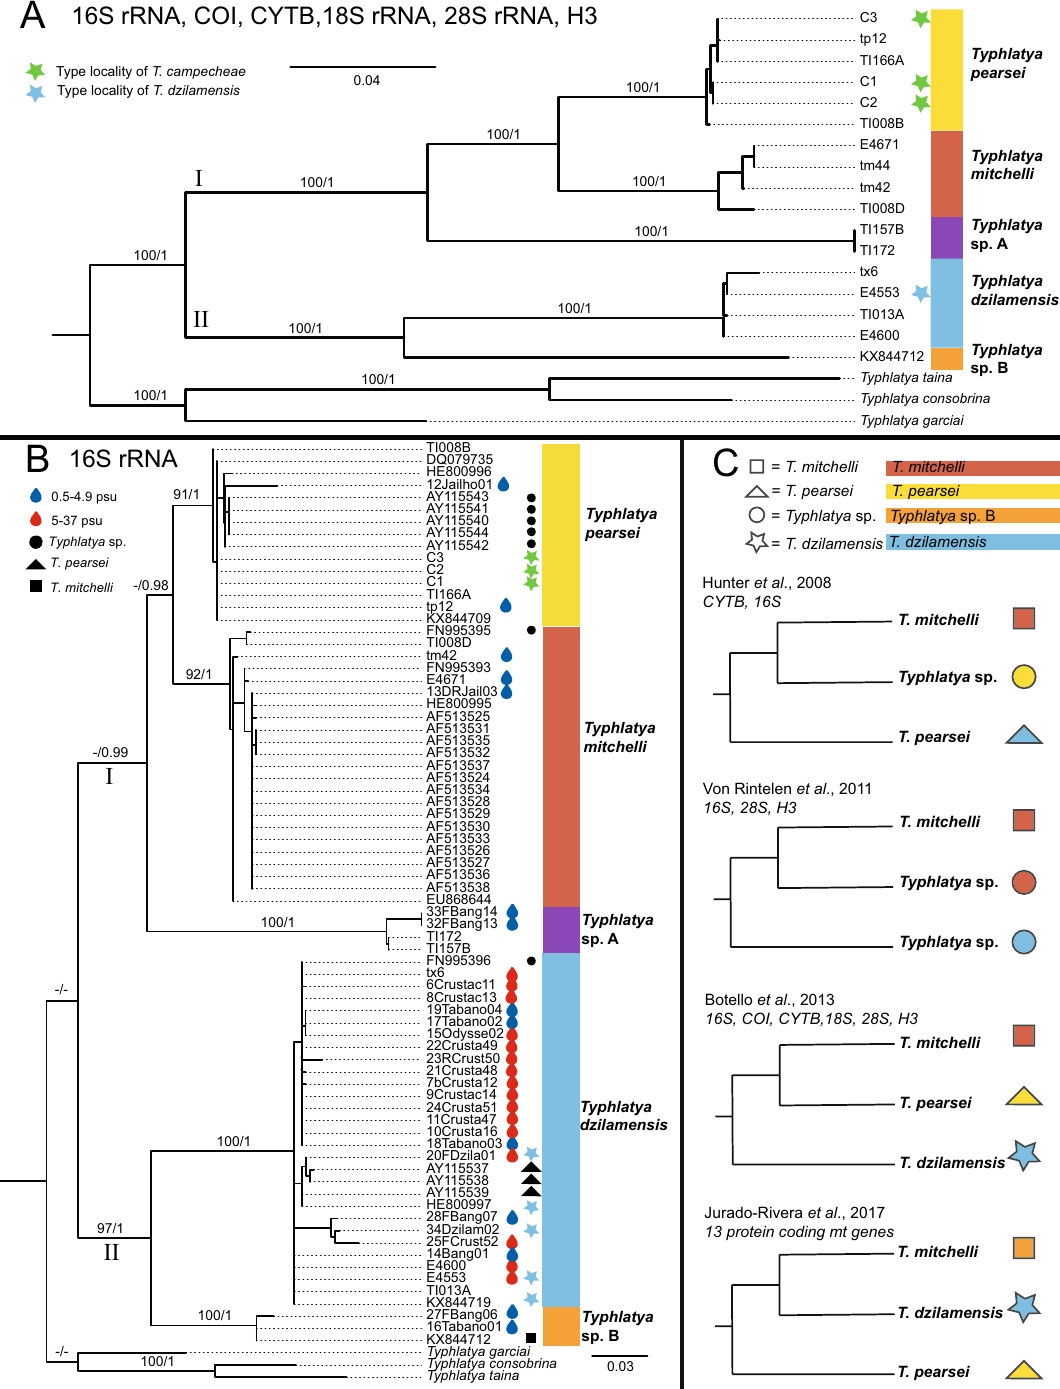
Figure 4. Phylogenetic hypotheses of Typhlatya spp. from the Yucatán Peninsula. ( A ) Multi-gene (16S rRNA, COI, CYTB, 18S rRNA, 28S rRNA, H3) phylogeny of select Typhlatya spp. sequences, Bayesian phenogram shown; ( B ) 16S rRNA phylogeny of GenBank and sampling new to this study, Bayesian phenogram shown; ( C ) Graphical summary of phylogenetic relationships from previous studies 21,22,30,31 . Support values indicated at nodes above branches: Bootstrap/Bayesian Posterior Probability. Supports values < 90/0.90, not shown (see text) and indicated by ‘–’. Colors represent species identity resulting from the molecular evaluations of this study ( A–C ): Typhlatya pearsei = yellow, Typhlatya mitchelli = red, Typhlatya dzilamensis = blue, Typhlatya sp. A purple, Typhlatya sp. B orange. Filled black shapes beside species’ identifications ( B ) indicate previous identifications of GenBank material in conflict with the present study: circle = Typhlatya sp., triangle = T. pearsei , square = T. mitchelli. Shapes beside species’ identifications ( C ) indicate species identifications from previous work: circle = Typhlatya sp., triangle = T. pearsei , square = T. mitchelli , star = T. dzilamensis . Sequences from specimens collected from type localities indicated by colored stars ( A,B ): green star = T. campecheae , Grutas de Xtacumbilxunam; blue star = T. dzilamensis, Dzilam de Bravo . Sequences from samples with known salinity (in psu) are indicated by colored water droplets ( B ), blue = low salinity, 0.5–4.99, red = high salinity,